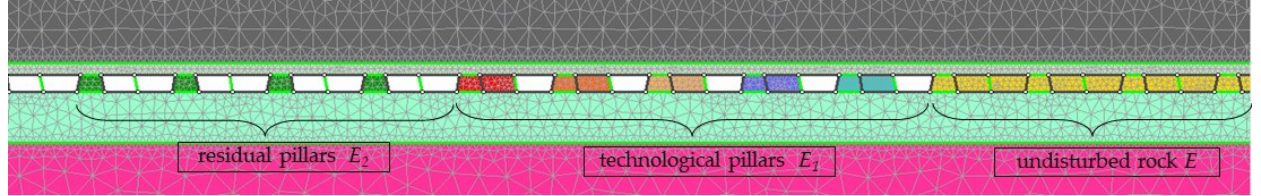
Figure 8. Fragment of the model of analyzed exploration field with marked division of pillars.